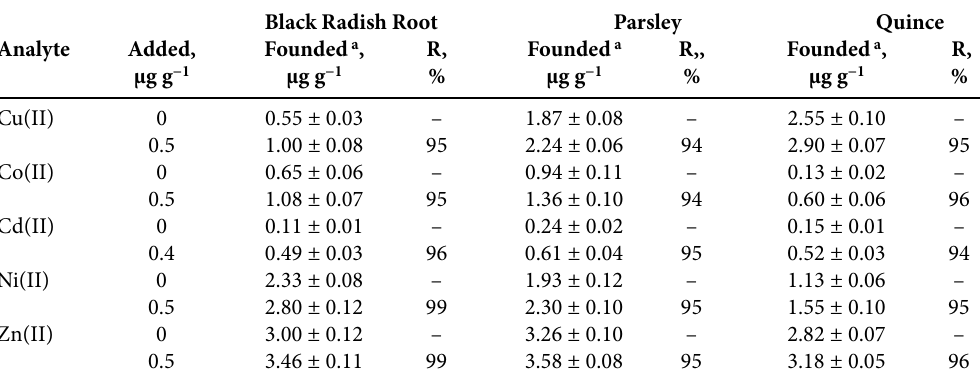
Table 7. Analysis of some salad vegetables spiked with analyte ions (n = 4)